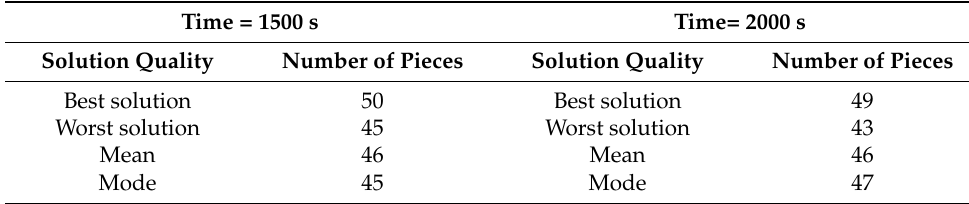
Table 3. ILS behavior with different executions times.